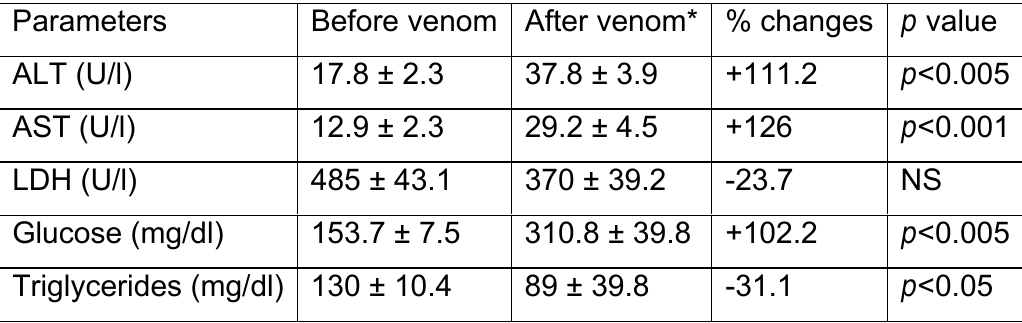
Table 1: Effects of O. doriae venom on rabbits serum ALT, AST, LDH, glucose, and triglycerides (mean ± SEM).